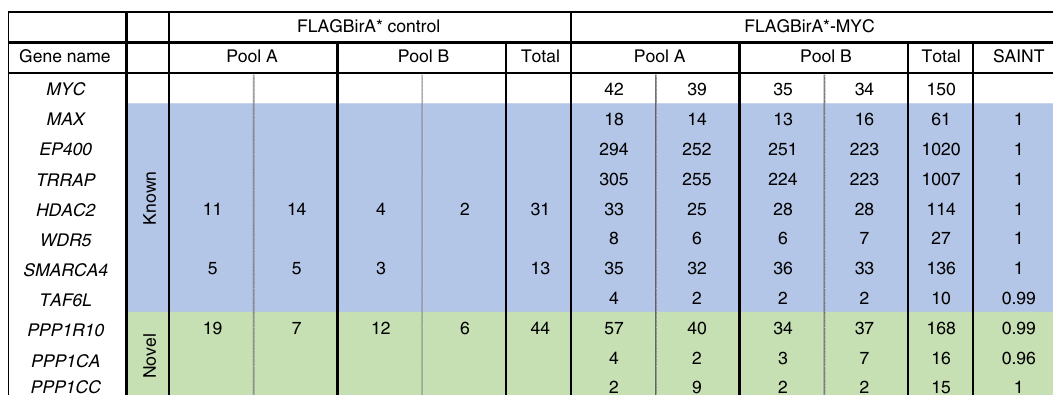
Fig. 3b images (left) and histogram (right)) cells and observed MYC-PNUTS interaction. To validate the speci fi city of the MYC PLA signal, we also performed PLA in HO15.19 MYC knockout cells. The MYC-null cells did not produce any fl uorescence signal,